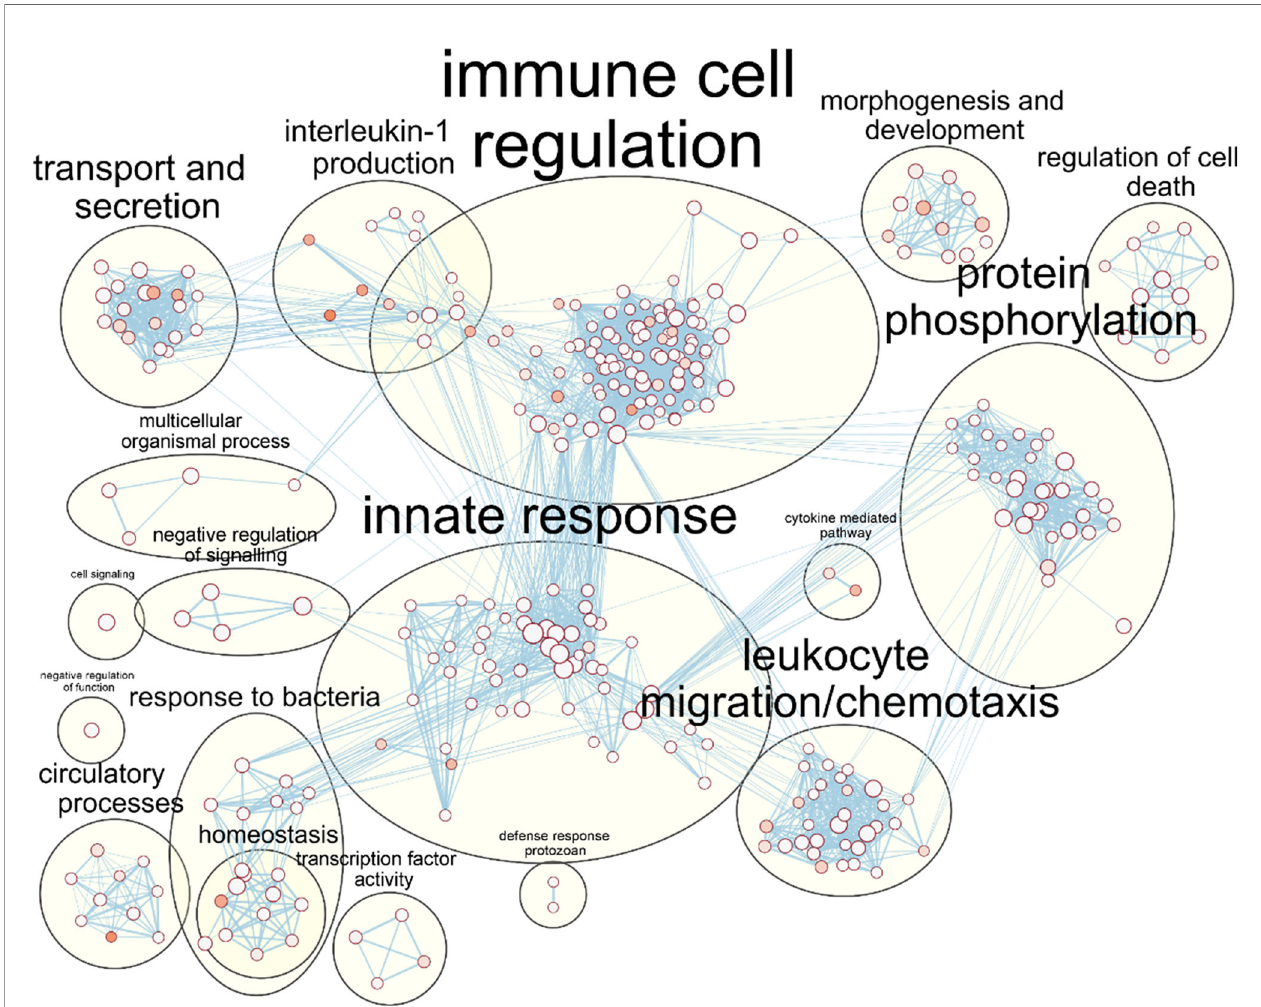
FIGURE 3 | Enrichment of macrophage immune responses during NTHi persistence. Enrichment analysis using ToppFunn identi fi ed over 500 signi fi cantly enriched biological processes which were clustered using EnrichmentMap and AutoAnnotate in Cytoscape to identify the key biological processes involved in the MDM response to NTHi. Nodes represent individual GO:terms, with size relating to the number of genes in each term and the colour indicating enrichment signi fi cance. Edges represent connections between nodes that share